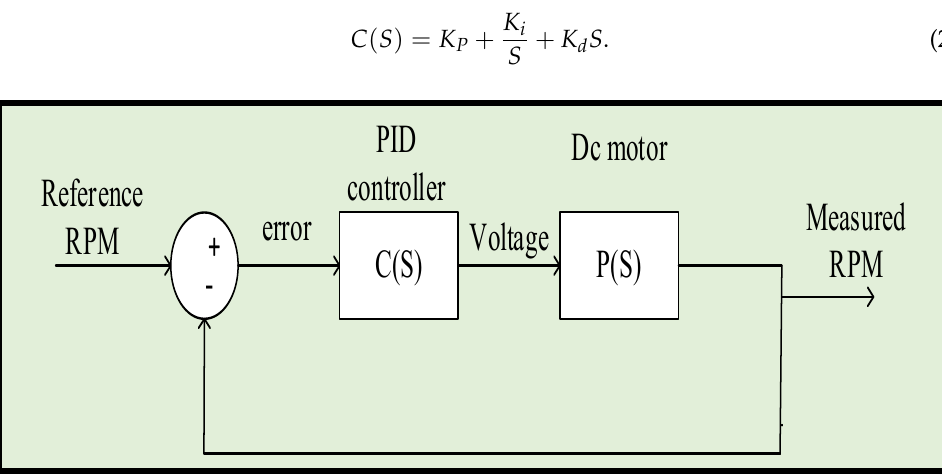
Figure 4. DC motor speed control using PID controller.